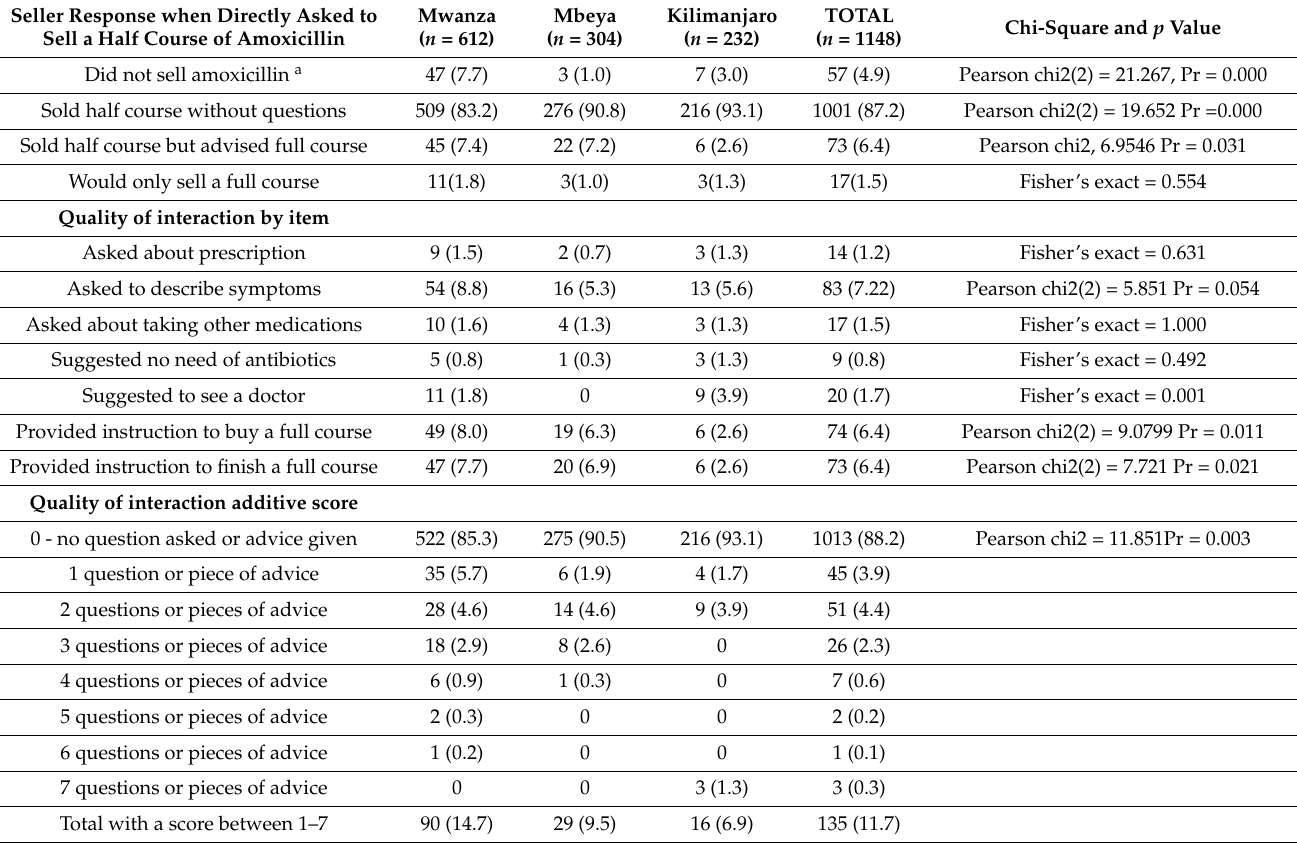
Table 2. Sellers’ dispensing practice and quality of interaction across the three regions.